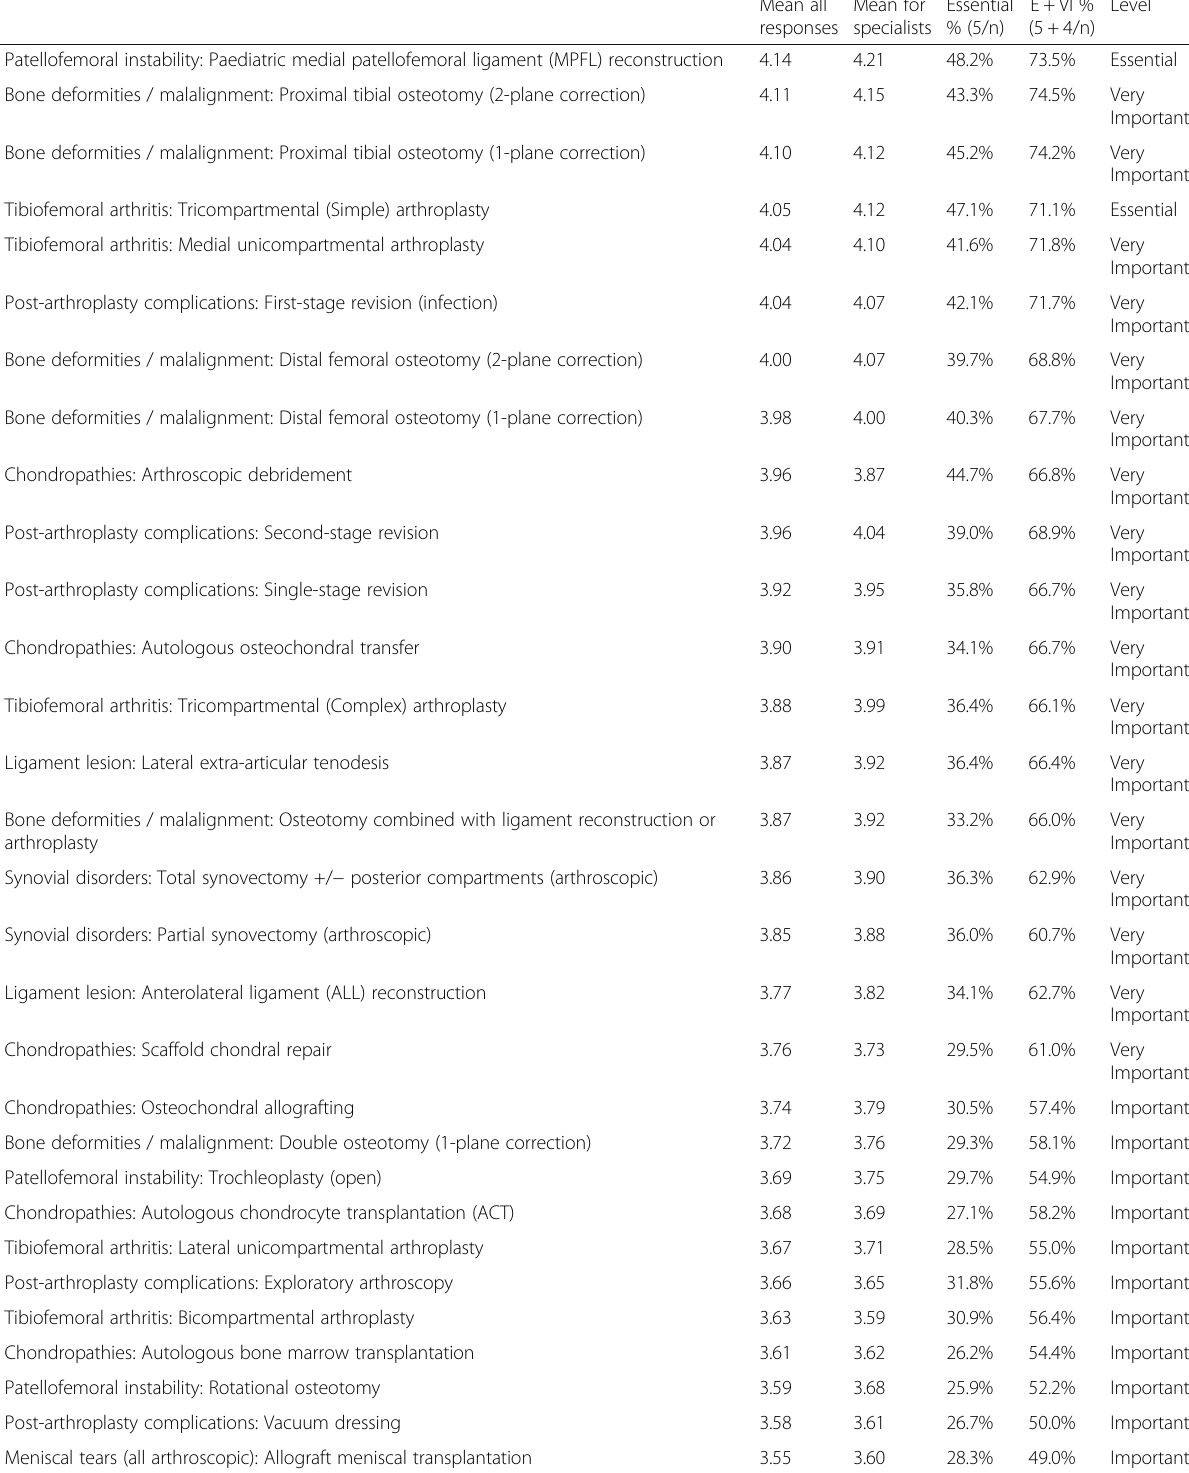
Table 2 For insertion in the results section as indicated above